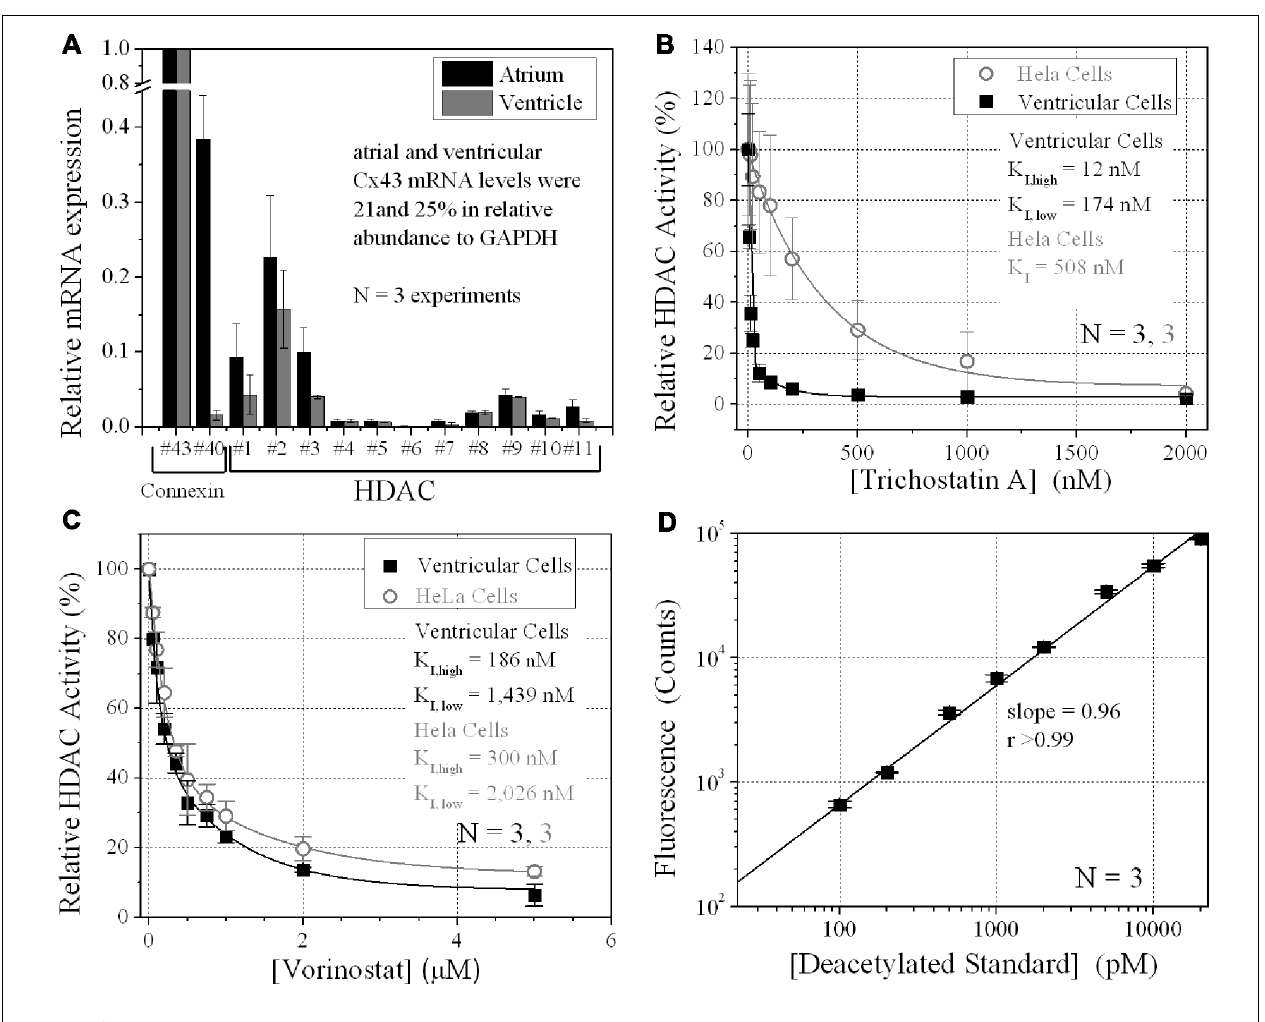
with a second-order exponential decaying function in Origin7.5 and the equilibrium inhibition constants ( K I ) were calculated from the expression K I = 0.693/[HDACI]decay constant. (D) A series of 1:10 dilutions of the deacetylated Fluor-de-Lys substrate were combined with the developer and fluorescence counts were obtained with the BIO-TEK Synergy plate reader in conjunction (i.e., parallel) with the cell-based HDAC activity assays.The background (empty well) subtracted fluorescence emission at 460 nm increased linearly with the concentration of the deacetylated substrate.The experiments were performed in triplicate (mean ±